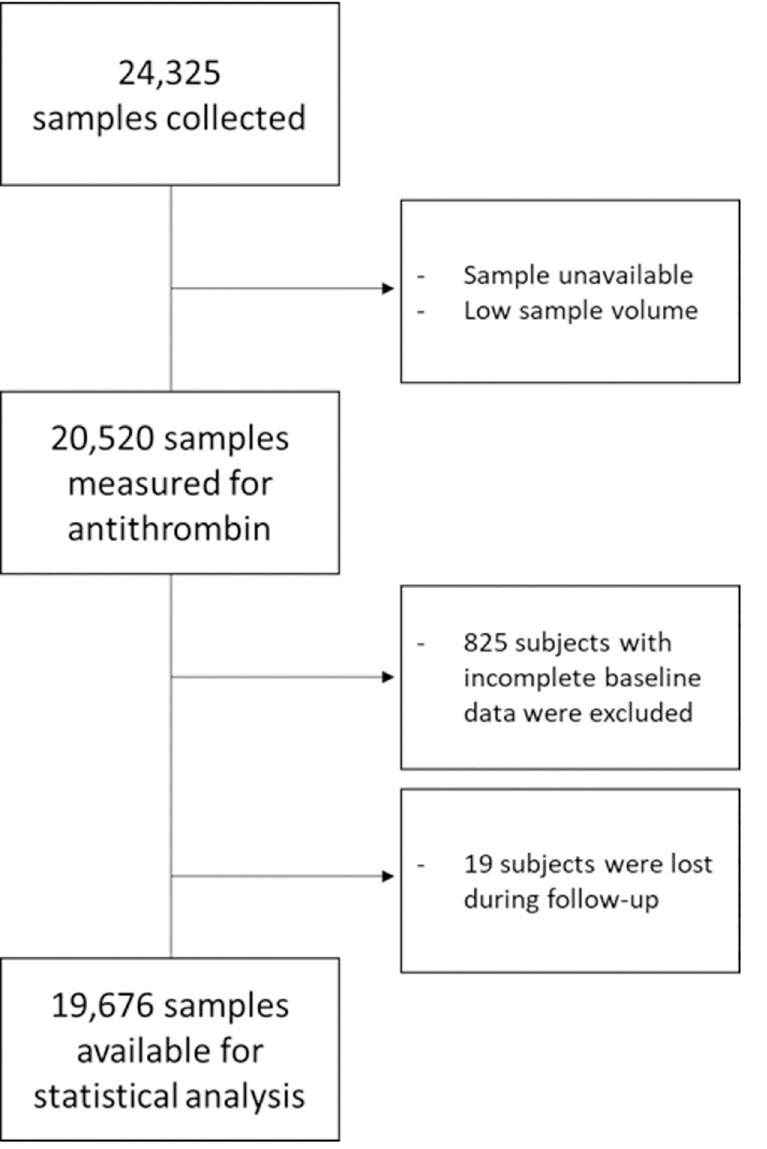
Fig 1. Flow chart of the selection of subjects for statistical